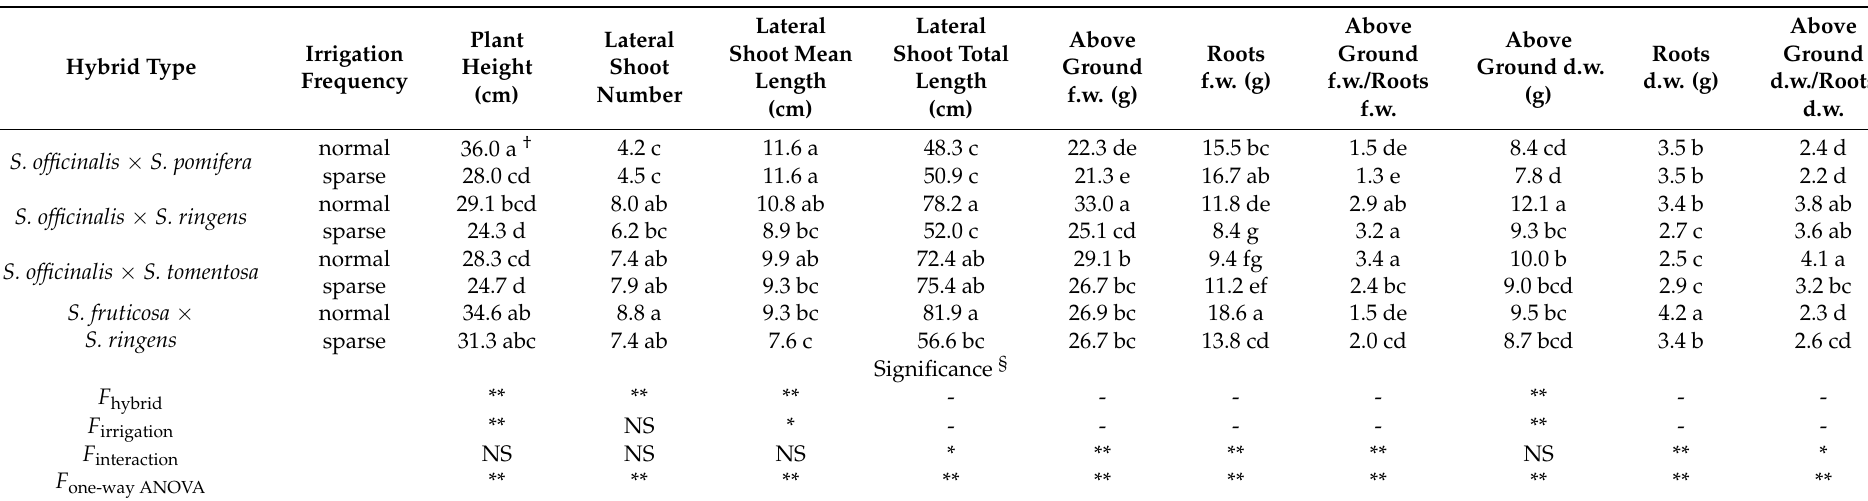
Table 5. Comparative evaluation of growth of four new interspecific hybrids of Greek sage species regarding resistance to water deficiency, after three months of greenhouse culture on peat: perlite 2:1 ( v / v ) with 25 g/L